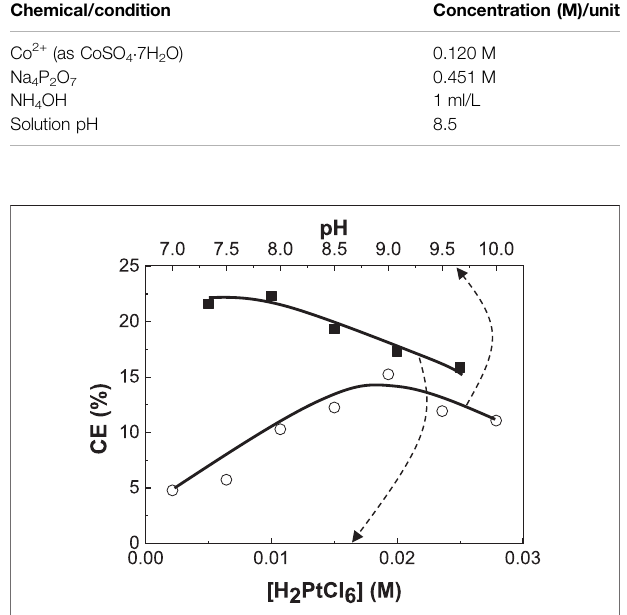
FIGURE 3 | Dependence of current ef fi ciency (CE) of CoPt thin fi lms on H 2 PtCl 6 concentration and solution